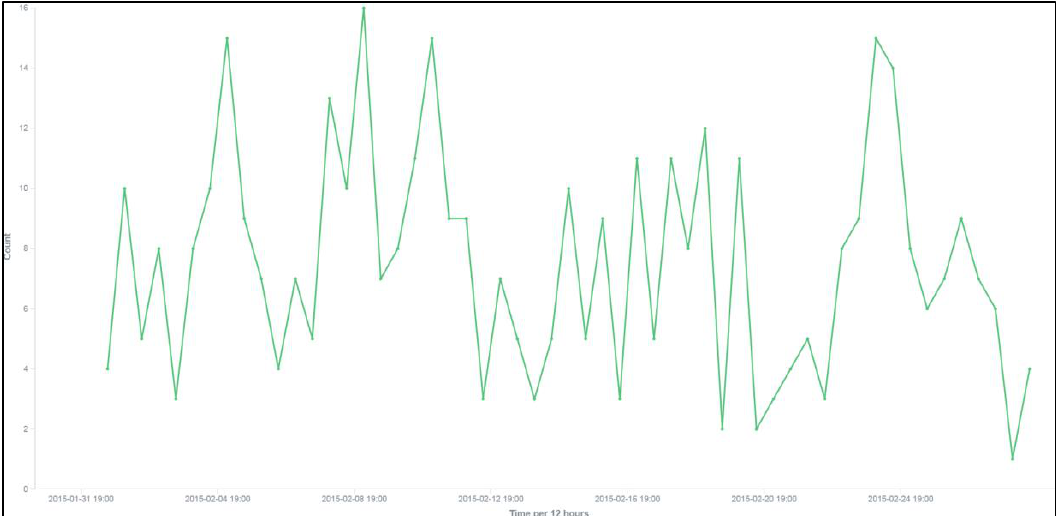
Figure 8. Website traffic.